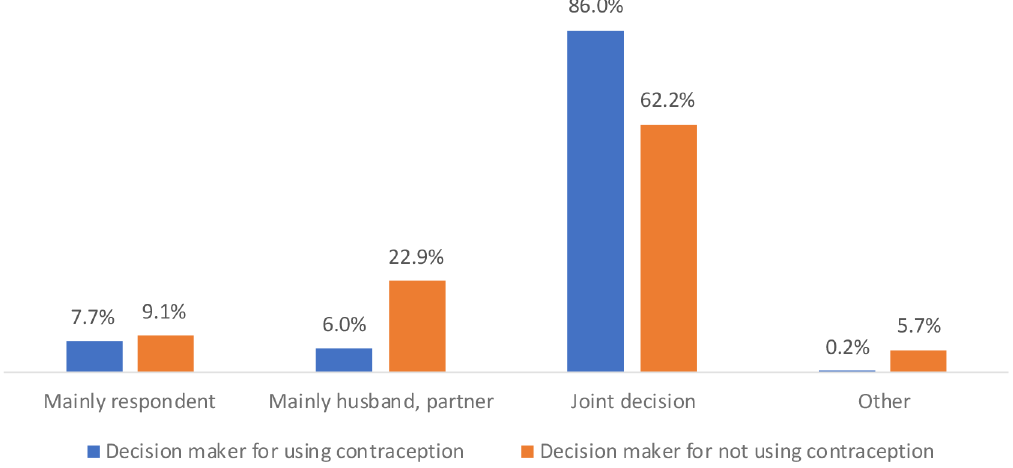
Figure 2. Percentage of husband or wife jointly making the decision to use or not to use contraception, 2012- 2018.* *Data on the decision of using contraception were available for two years only 2012-13 and 2017-18 and data regarding the decision of not using contraception were available for the year 2017-18 only.